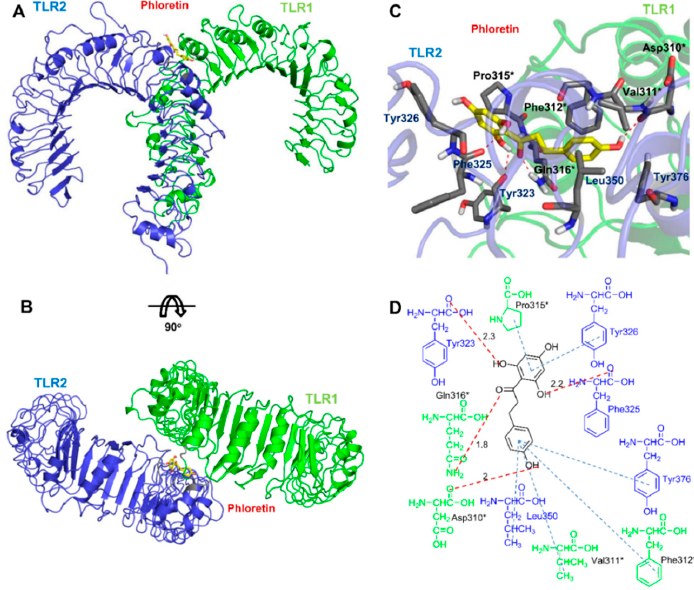
Figure 6. Model of phloretin binding to TLR2/1. ( A ) Overview of the TLR2/1–phloretin complex built using the X-ray structure of the TLR/1 complex (PDB ID: 2Z7X). TLR2, TLR1, and phloretin are displayed as a blue ribbon, green ribbon, and yellow stick, respectively. ( B ) Top view of phloretin in the predicted binding mode. ( C ) Active-site view of the docking pose. TLR2 and TLR1 residues participating in the interaction with phloretin are shown as gray sticks. Asterisks (*) denote TLR1 residues. Hydrogen bonds are shown as red dotted lines. ( D ) Two-dimensional depiction of the binding model. Hydrogen bonds and hydrophobic interactions are shown as red and blue dotted lines, respectively. Hydrogen bond distances (in angstroms) are shown above the dotted lines. TLR2 (blue) and TLR1 (green) residues participating in hydrogen bonding and hydrophobic interactions are shown.